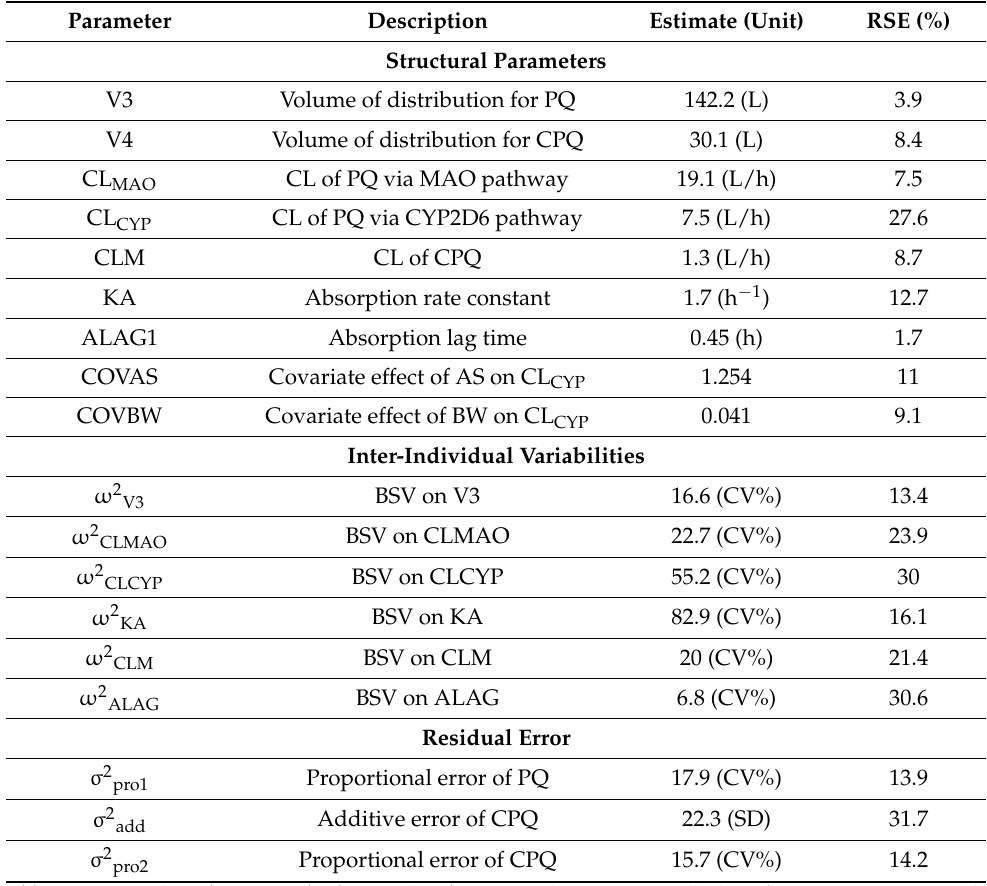
Table 2. Final model parameter